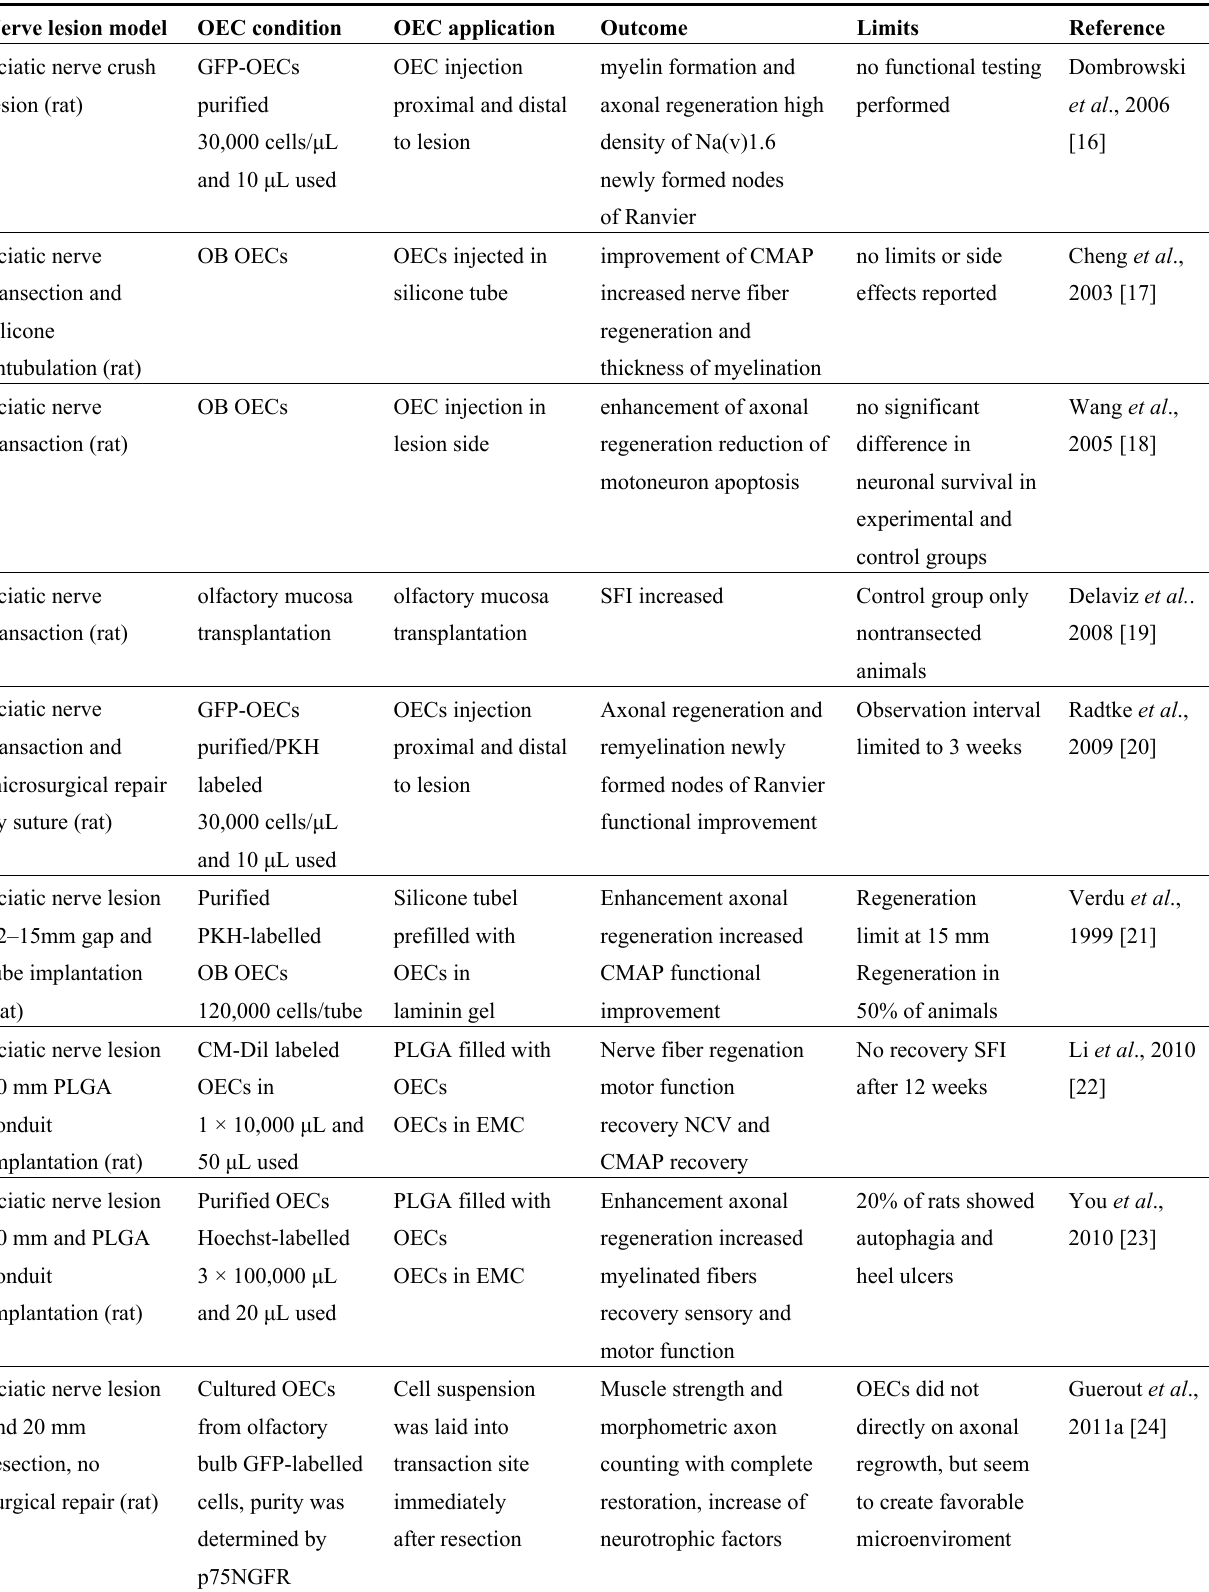
Table 1. Summary of olfactory ensheathing cell (OEC) transplantation studies into peripheral nerve injury